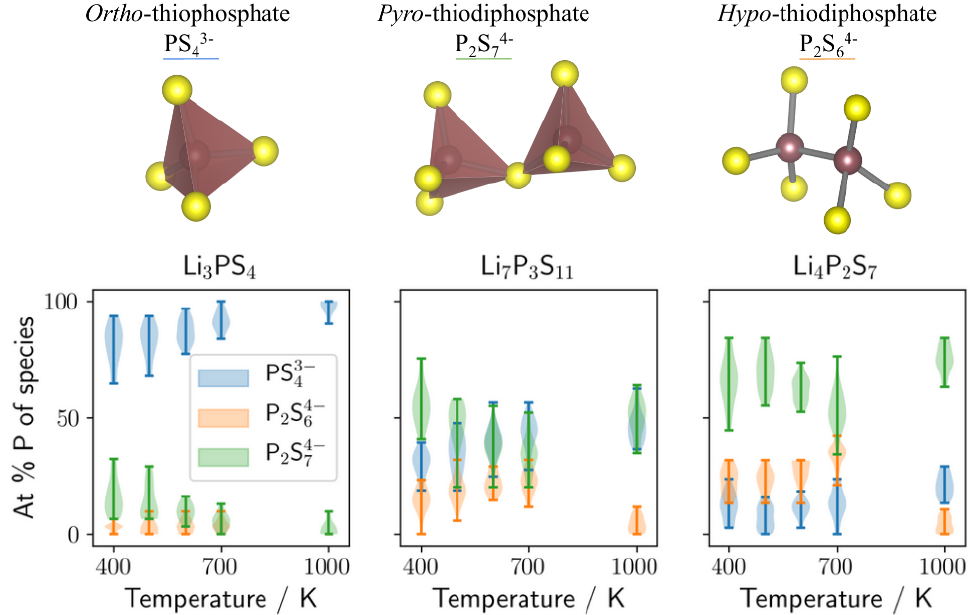
Figure 3. Top : Dominant anions in the Li 2 S–P 2 S 5 material class. Bottom : Anion compositions for different MD temperatures, displayed for Li 3 PS 4 ( left panel), Li 7 P 3 S 11 ( middle panel), and Li 4 P 2 S 7 ( right panel)